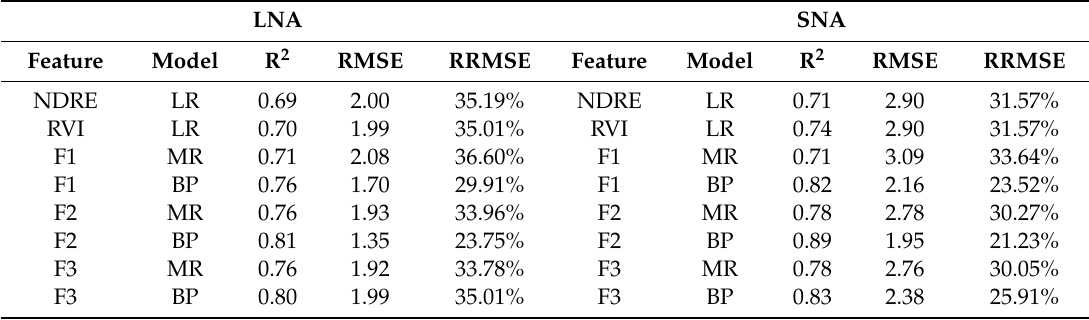
Table 6. Comparison of LNA and SNA estimates derived from di ff erent features in the heading stage. LNA SNA Feature